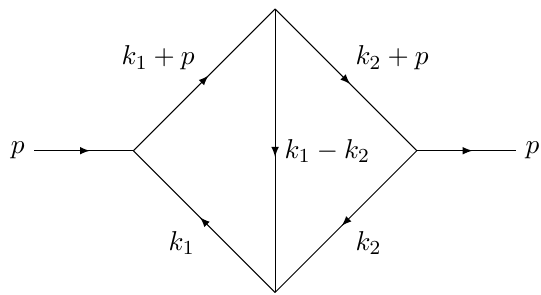
Figure 24. The double-triangle diagram in terms of a particular choice of loop momentum basis and momentum